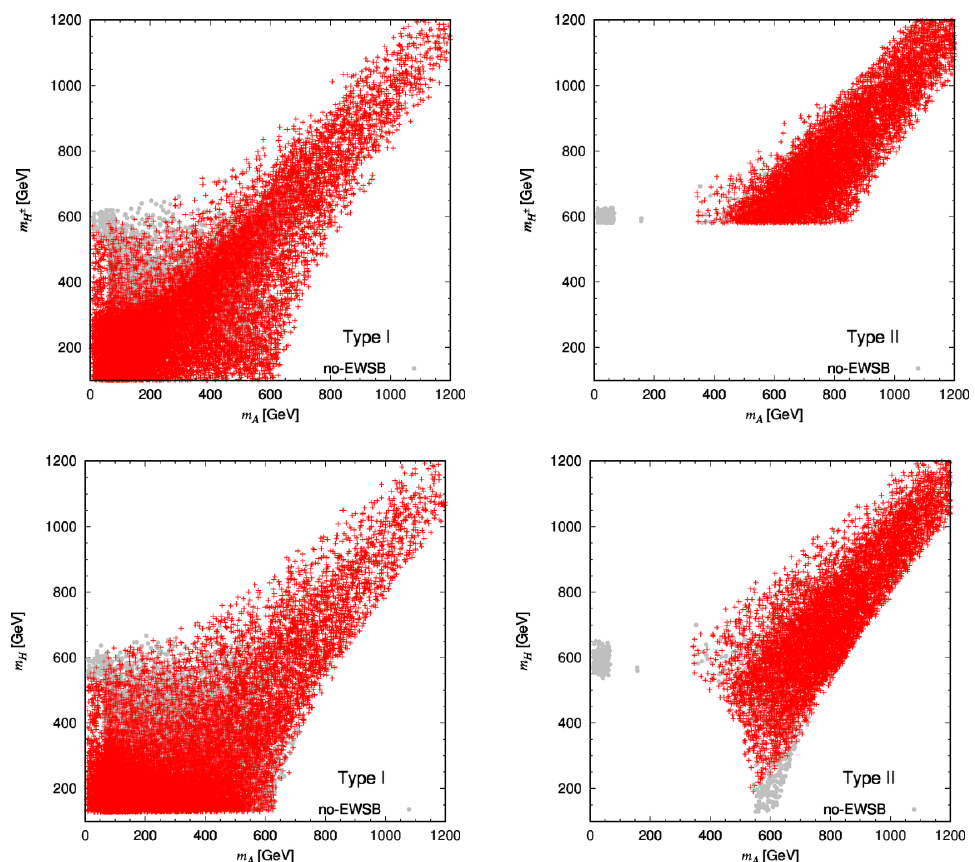
Figure 1 . The allowed mass spectra (up to 1.2 TeV) of the BSM Higgs bosons confronting with LHC Run-2. In Type II (right), the B-physics constraint on the charged Higgs m is imposed and nearly excludes the low m A points. Gray points indicate EWSB is not ensured at zero temperature when one-loop e(cid:11)ect is included in the Higgs